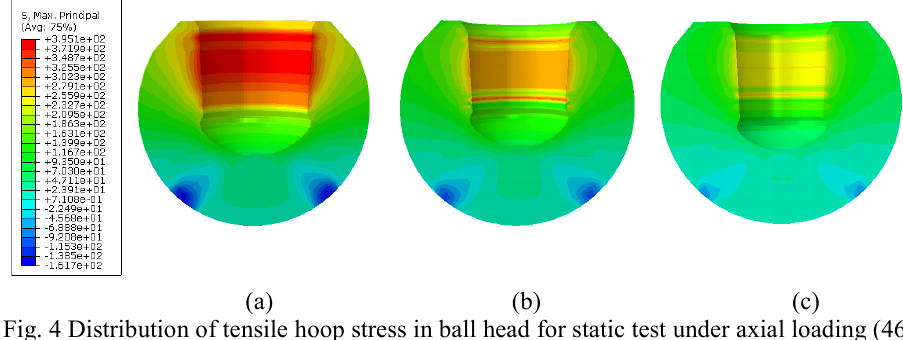
Fig. 4 Distribution of tensile hoop stress in ball head for static test under axial loading (46 kN) against 100 ° support. Ball head diameters: (a) 28 mm (b) 32 mm and (c) 36